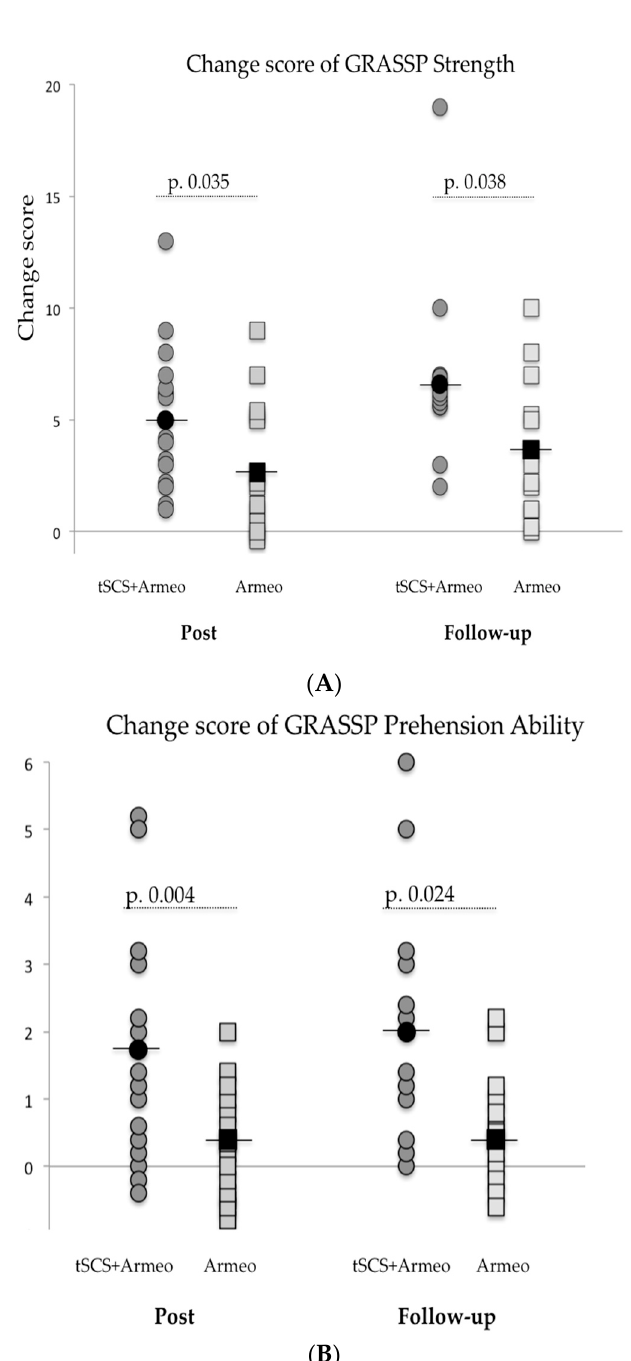
Figure 3. ( A ): Changes scores of strength subtest GRASSP; ( B ): Changes scores of prehension ability subtest GRASSP. Grey circles and squares represent each subject. Black circles and squares are the mean of the group. The p -value according to the Mann-Whitney U